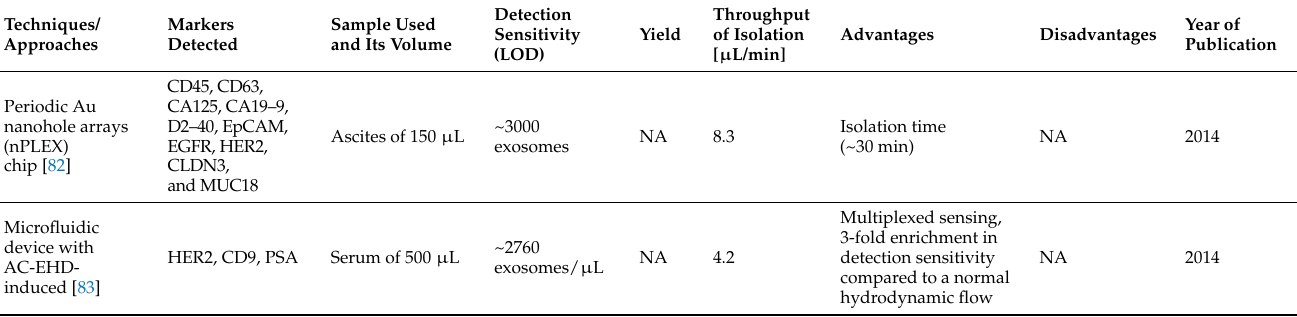
Table 2. Immunoaffinity approach integrated with microfluidics technique and nanoplasmonic detections to capture and detect